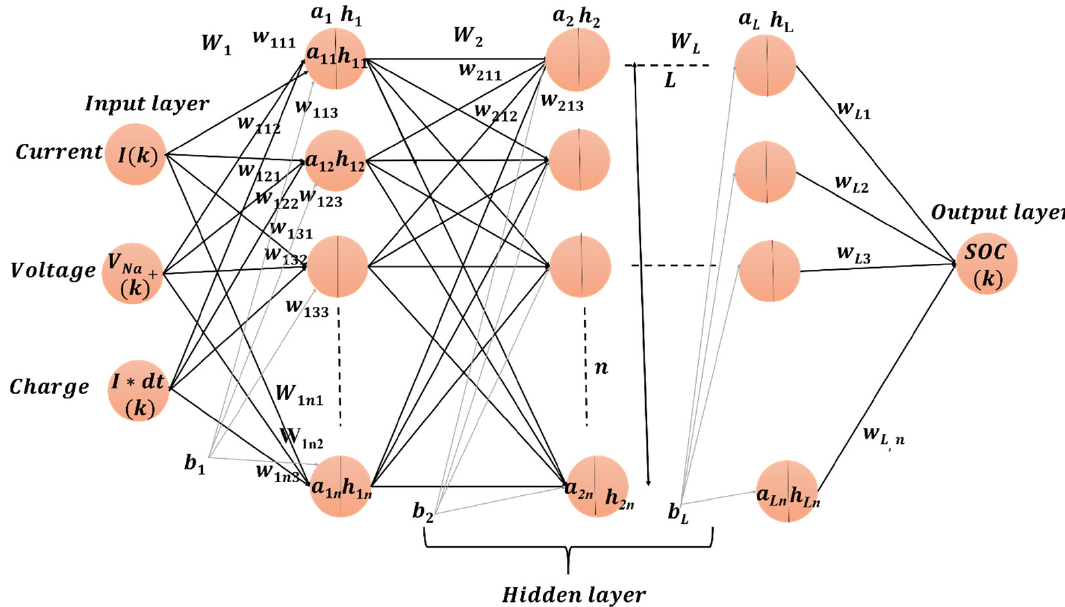
Figure 2. Architecture of a Deep Neural Network with L number of layers and n number of neurons at each layer. Weight and bias are associated to the corresponding layer and a detailed explanation is given in the main text. The input data are given as current, voltage, and charge at each time step and output of DNN estimates the SOC at every time step.